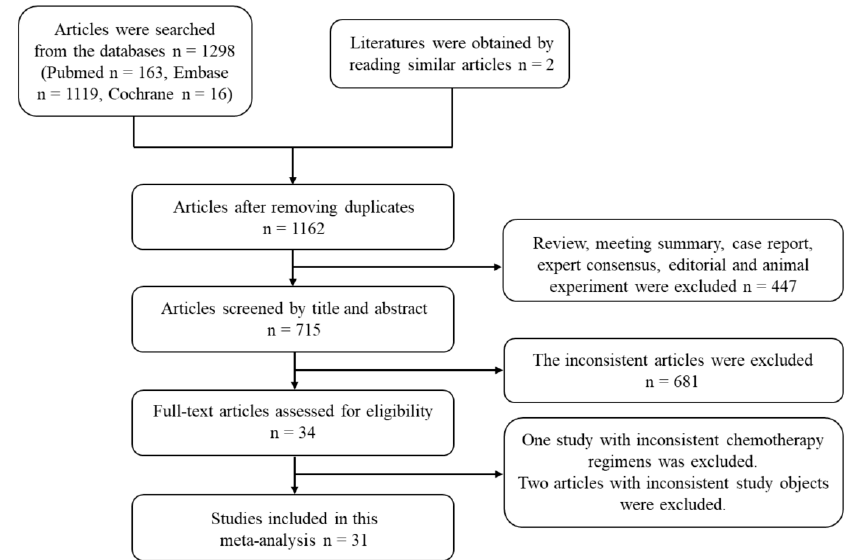
Figure 1. Flow diagram of the selection process for included studies in the systematic review. Among these articles, 14 were from China, 4 were from the United States, 3 were from Germany, 2 were from Canada, 2 were from the Netherlands, 1 was from Italy, 1 was from Australia, 1 was from India, 1 was from Thailand, and 2 were multicenter studies. A total of 12 articles included the treatment strategy of dCRT or concurrent chemoradiotherapy (CCRT), 14 involved nCRT, and 5 included dCRT/ CCRT and nCRT. Among the 3432 pa- tients included, 2477 had ESCC, 945 had EAC, and 10 had other pathological types. The characteristics of these selected studies are shown in Table 1 and Table S1. Table 1. Characteristics of 31 selected studies included in the systematic review and meta-analysis. Authors